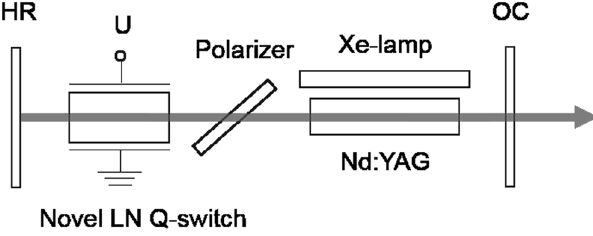
Figure 2. Experimental setup of the novel LN EO Q-switched Nd:YAG laser.